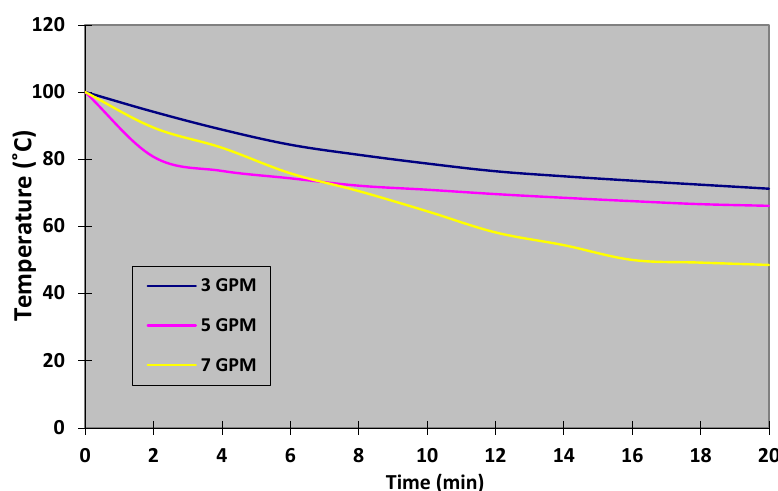
Figure 6. Surface temperature for the 100% distilled water.